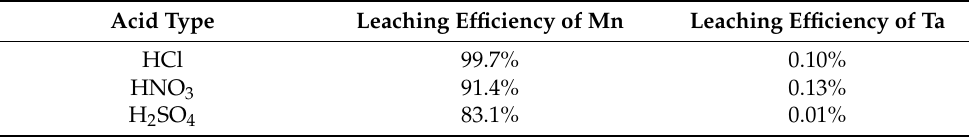
Table 4. The leaching efficiency of manganese and tantalum with three kinds of inorganic acids. Acid Type